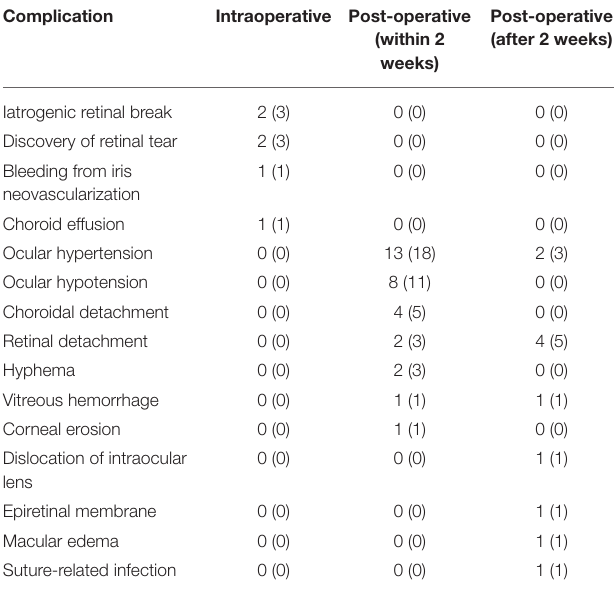
8.1% and 9.3% of all eyes, respectively (12). In contrast, none of